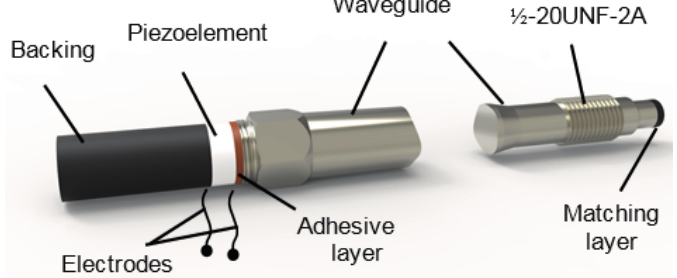
Figure 3. Ultrasonic transducer with a waveguide.